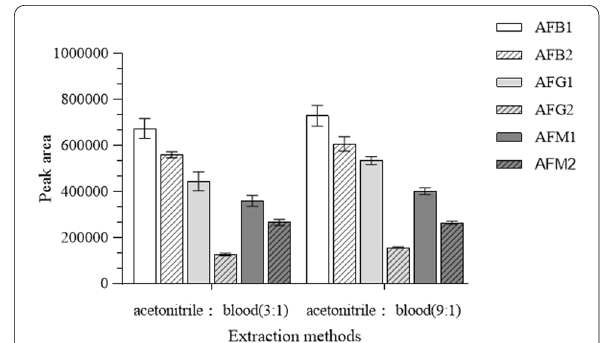
Fig. 3 Comparison of the peak areas of aflatoxins (4 ng/mL) in spiked blood sample using acetonitrile extraction at different volumes ( n 3) =